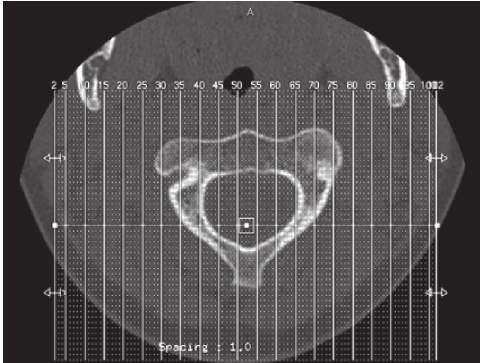
Figure 2: CT scans at follow-up of patient 1 show realignment of the atlas with the